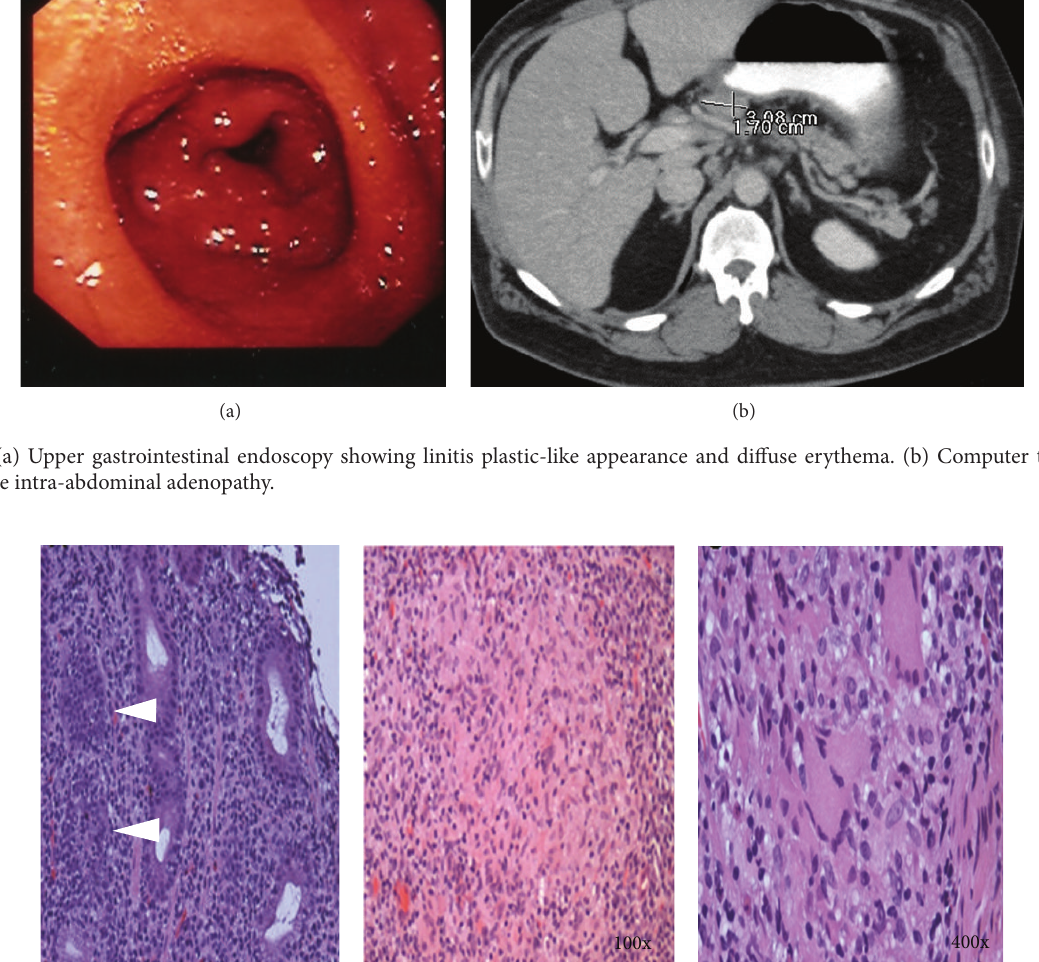
a tapering dose of prednisone for a period of 6 months with no recurrence of symptoms in 2